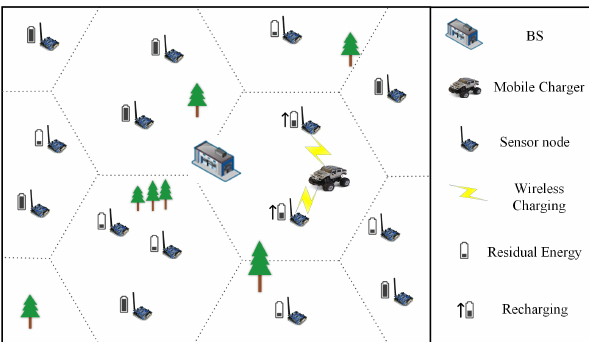
Figure 2. Overview of